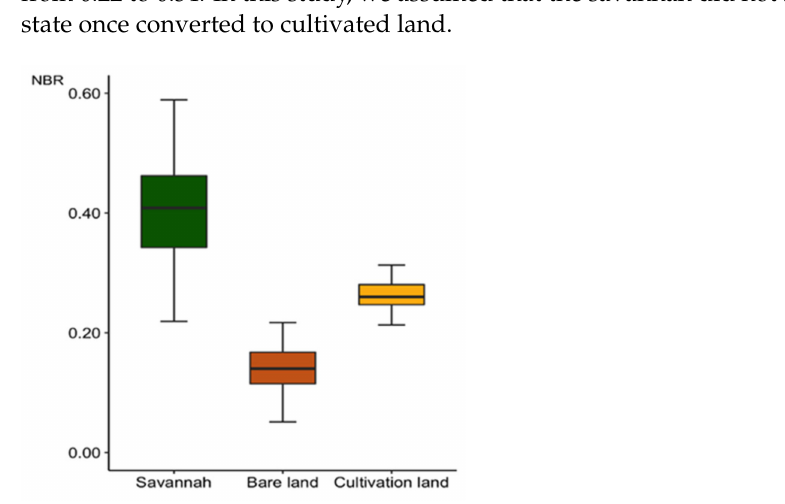
Figure 3. Spectral values of the normalized burnt ratio ( NBR ) for sample pixels (n = 300) of savannah, bare land, and cultivated land in the study